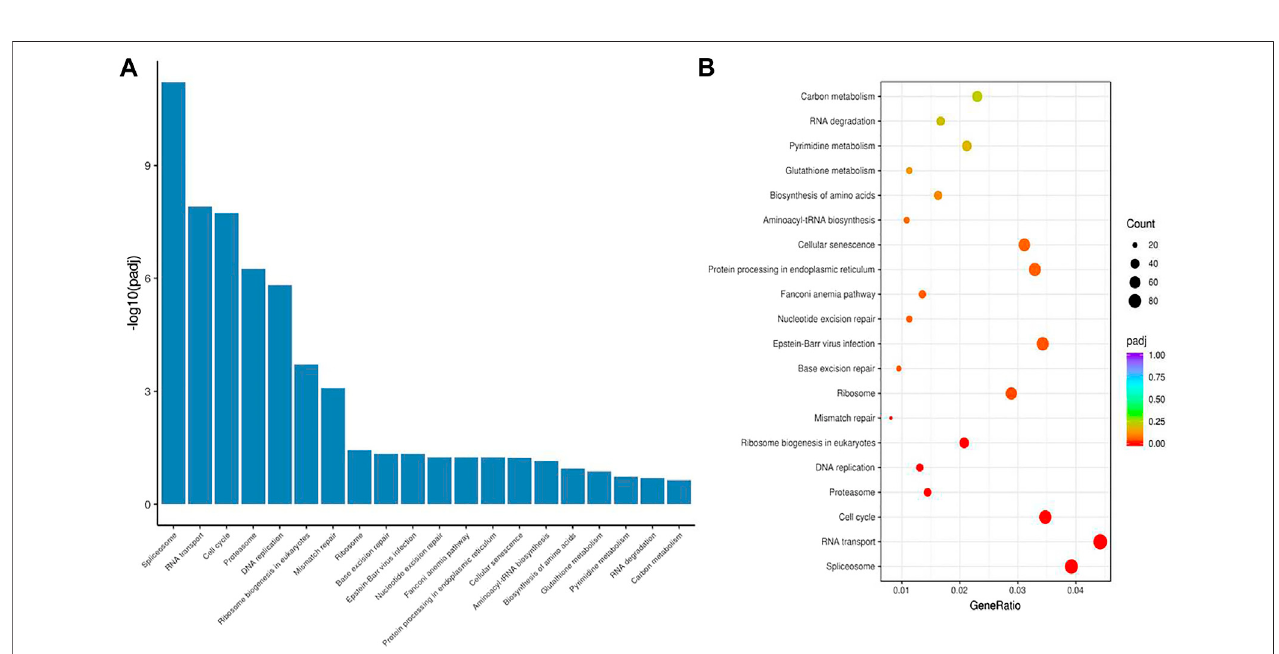
FIGURE4| Thesignaling pathways enriched forsigni fi cantdifferentially expressed genes inHuR KDA549cells versus control cells. Thehistogram (A) and bubble chart (B) of the KEGG results show that HuR mainly regulates pathways related to the spliceosome, RNA transport, and the cell cycle.